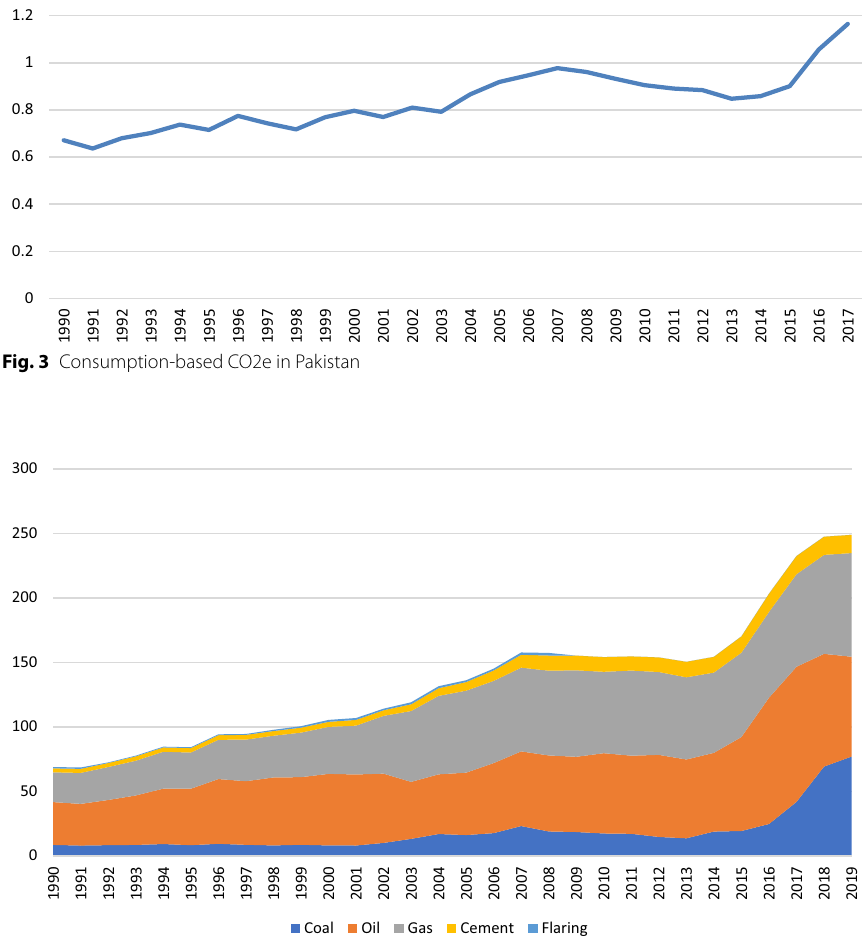
Fig. 4 The contribution of various sources to production-based CO2e in